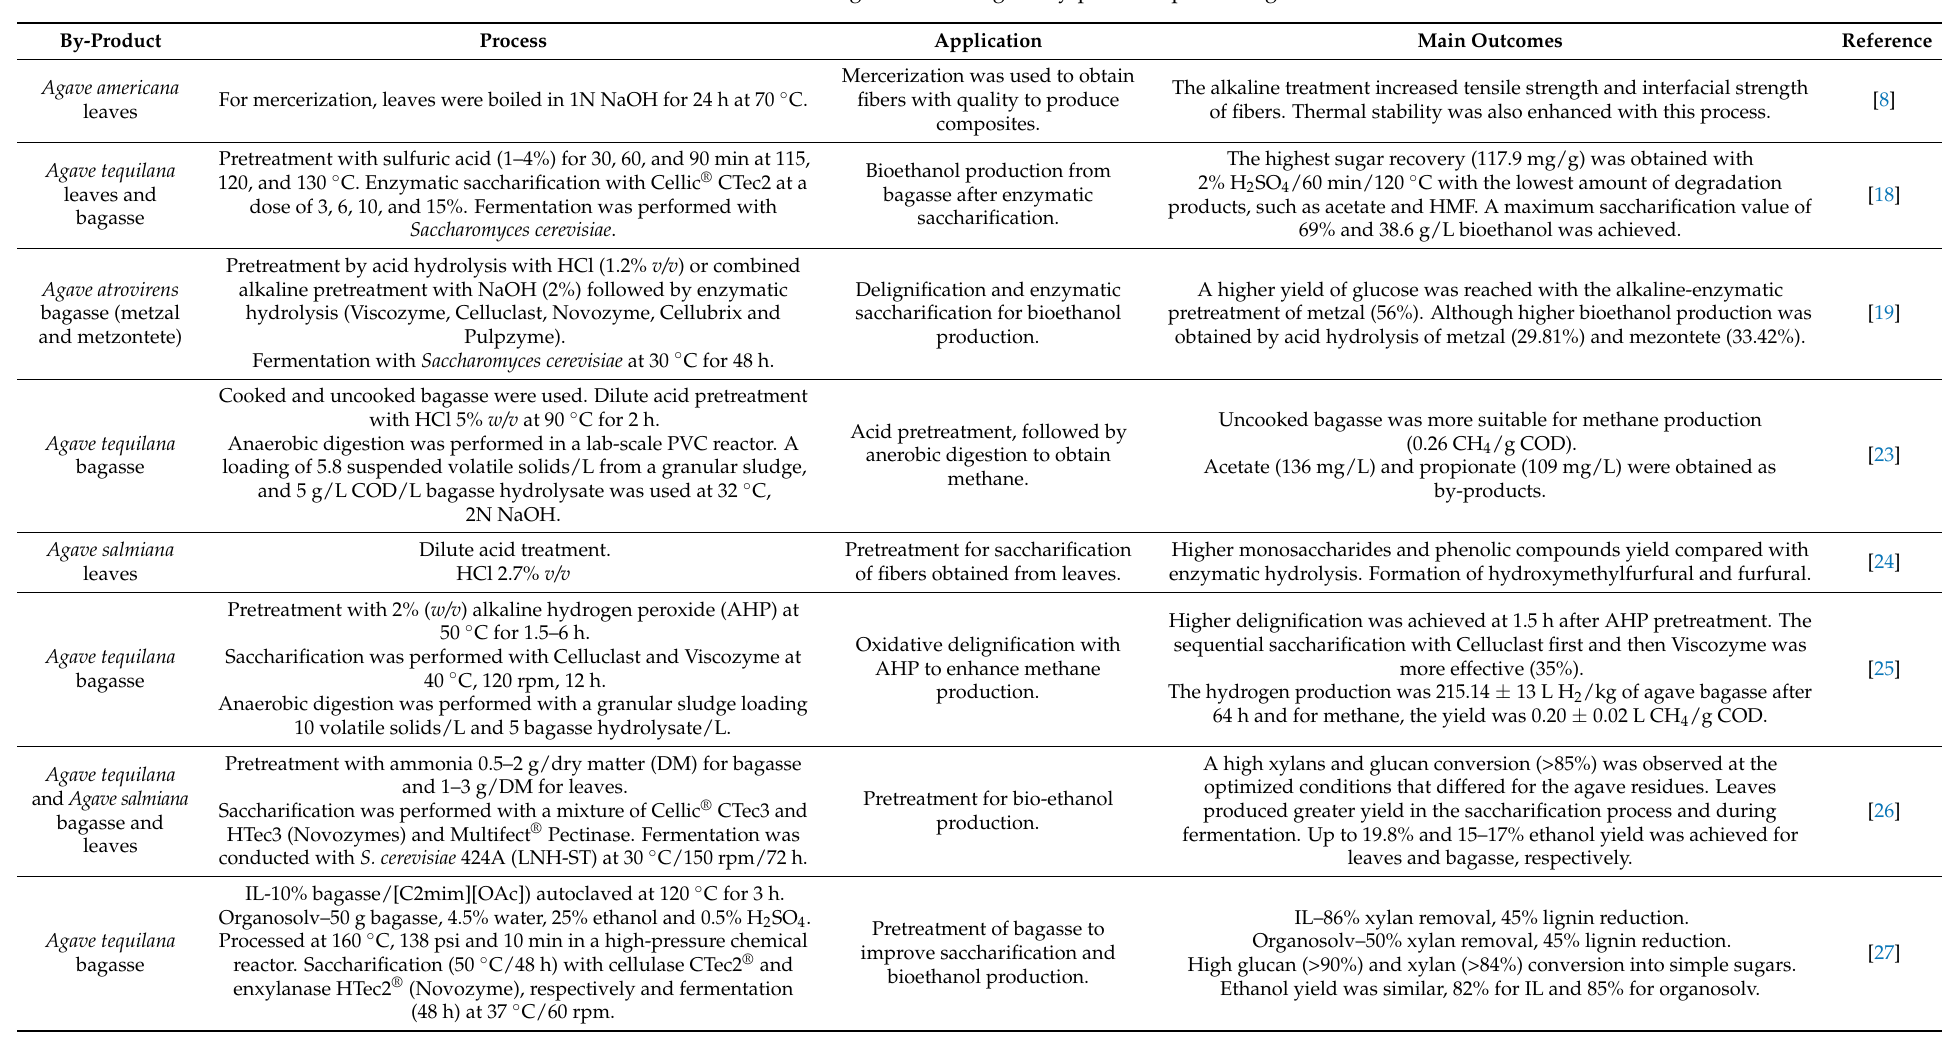
Table 3. Technologies used for agave by-products